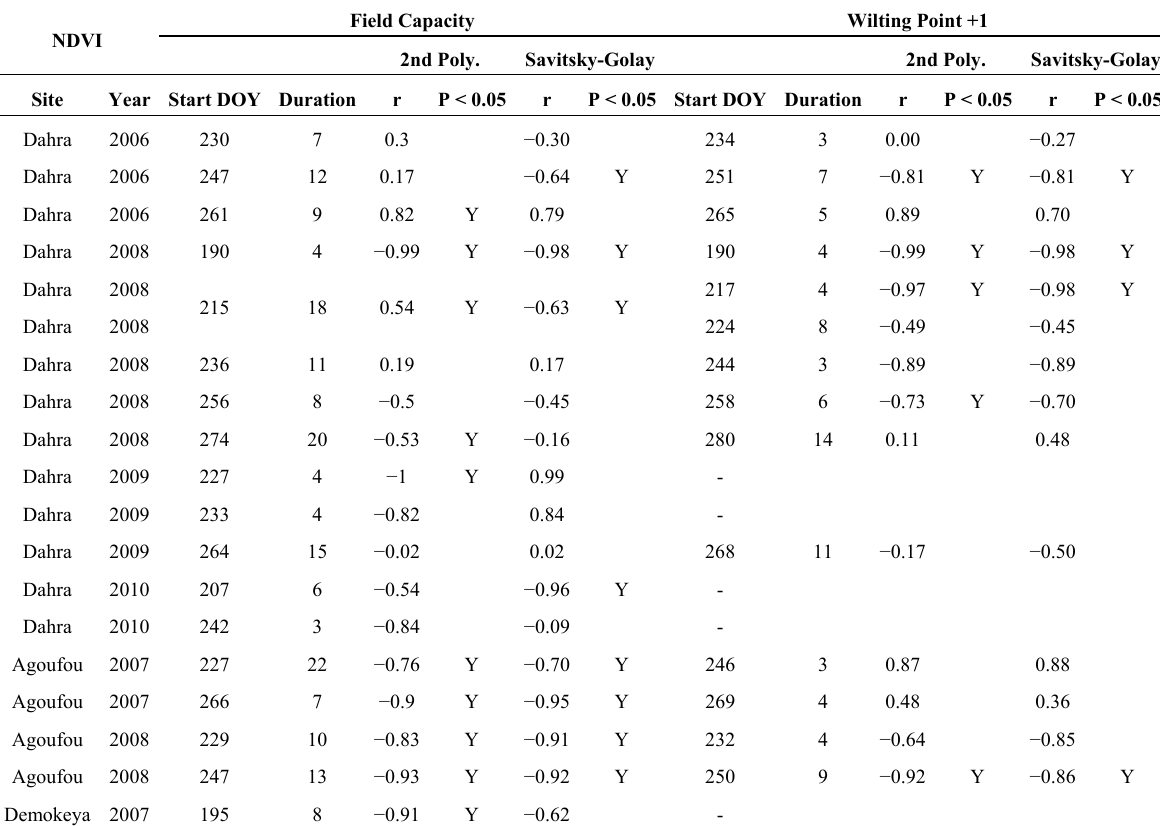
Table 6. Overview of Normalized Difference Vegetation Index (NDVI) anomalies and events when low plant available water was observed. Correlation coefficients (r) between number of days after Soil Moisture Content (SMC) dropped below Wilting point ( WP) + 1 or Field capacity (FC) (vol.%) and NDVI anomalies are noted, and p-Values have been calculated based on r and duration in days and marked with Y if p < 0.05. Only events of at least three days duration are